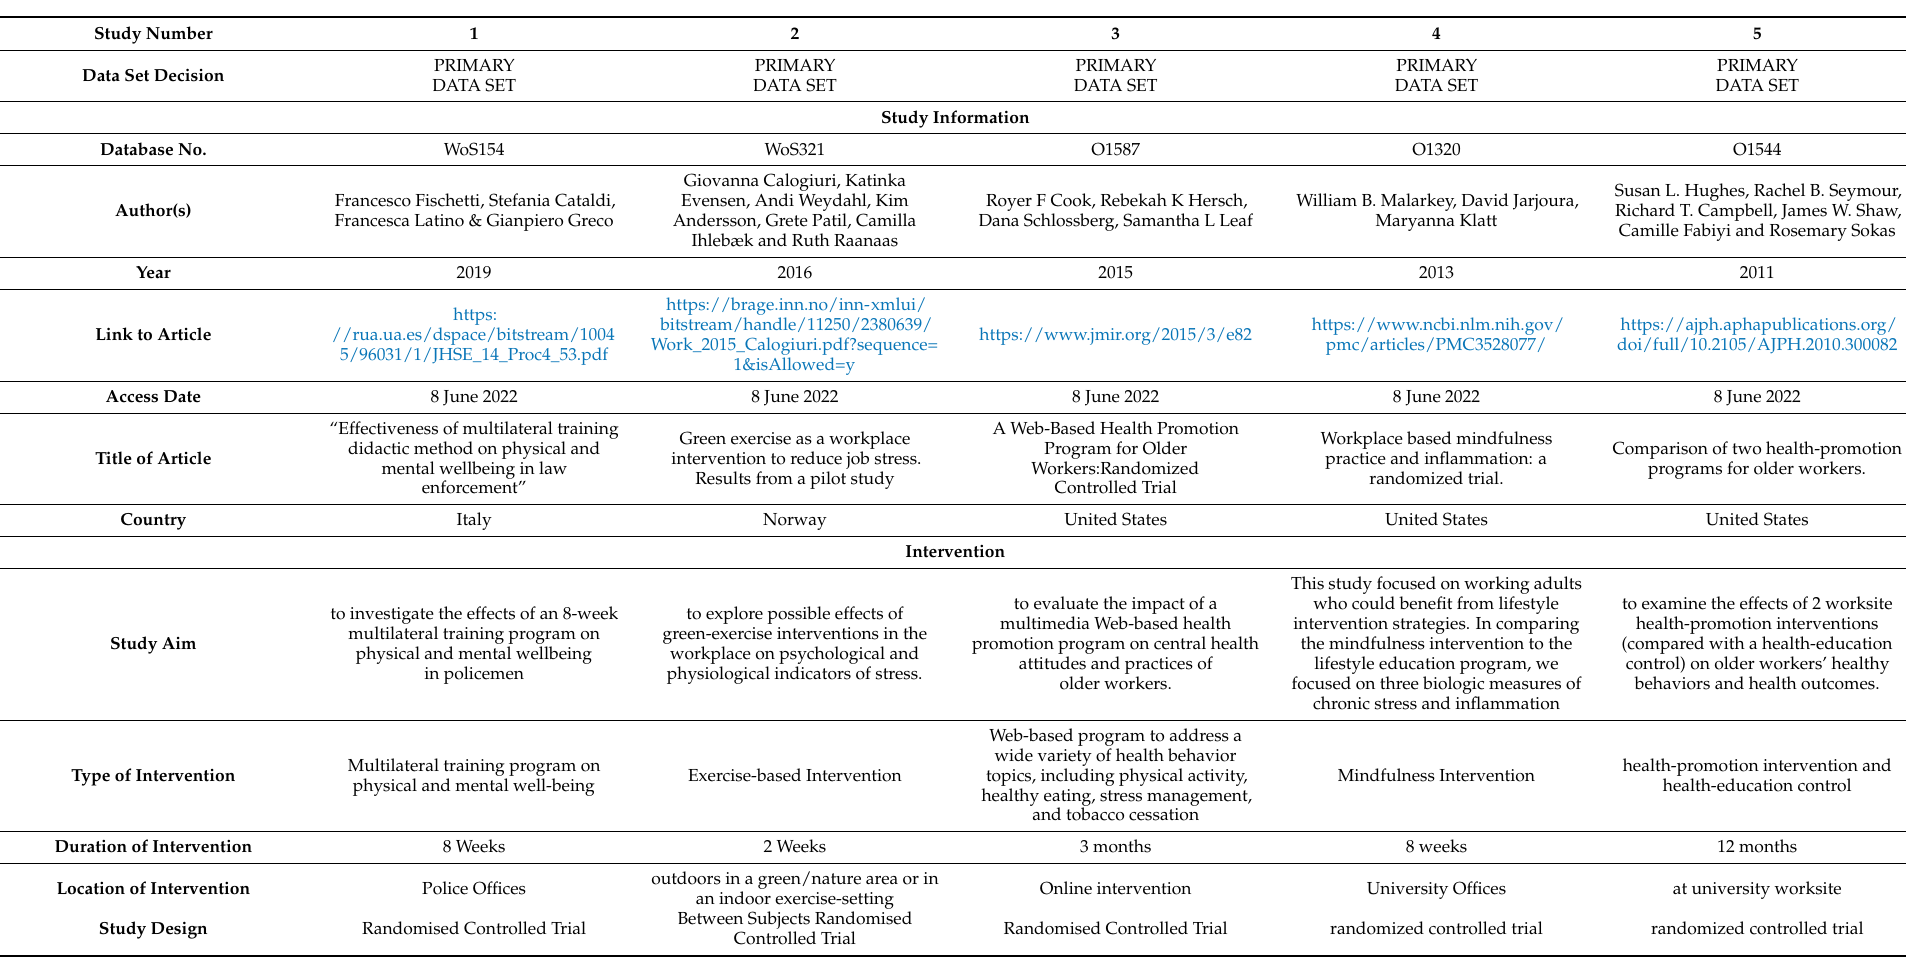
Table A1. Data Extraction Form from Primary